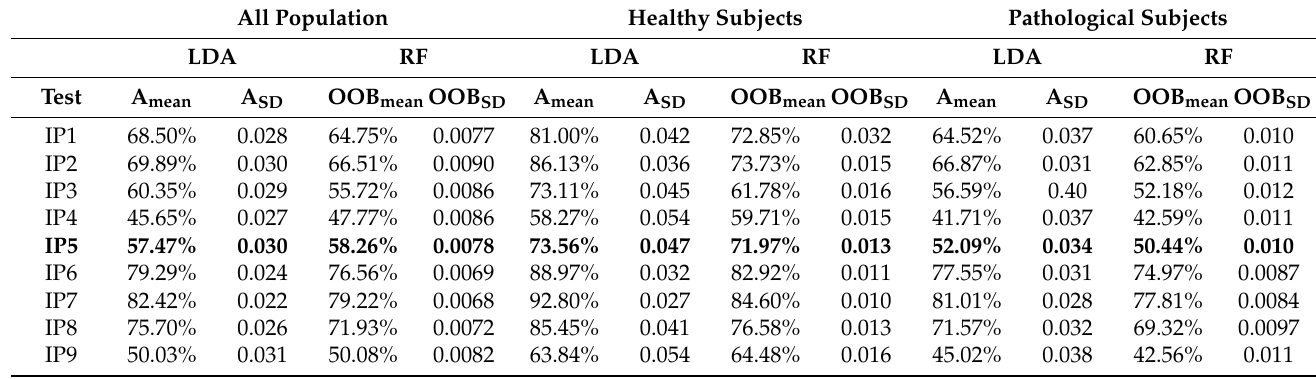
Table 3. Results of the performed tests on the complete dataset and the subsets of data acquired by heathy subjects and pathological patients. For each data sample, mean and SD of accuracy A and OOB are presented for LDA and RF, respectively. In bold font the data referring to tests without distinction of left and right limb. Healthy Subjects Pathological